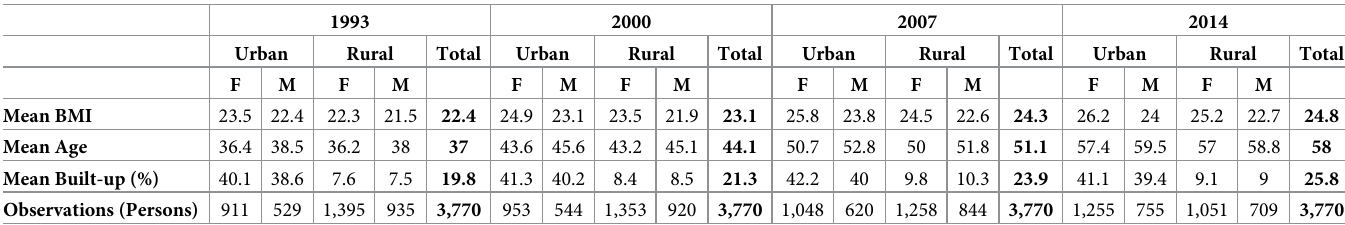
Table 1. Sample means by panel year, residence, and